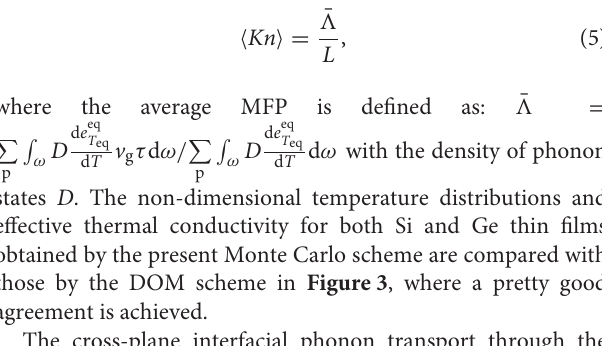
FIGURE 3 | The non-dimensional temperature distributions and the effective thermal conductivity of cross-plane phonon transport through Si and Ge single-layer thin films: (A,B) are non-dimensional temperature distributions for Si and Ge, including three cases with a thickness 7, 50, and 700nm, respectively. Symbols are the results calculated by Monte Carlo scheme and chain lines are those derived by DOM scheme; (C) is the effective thermal conductivity for Si and Ge thin films at different average Knudsen